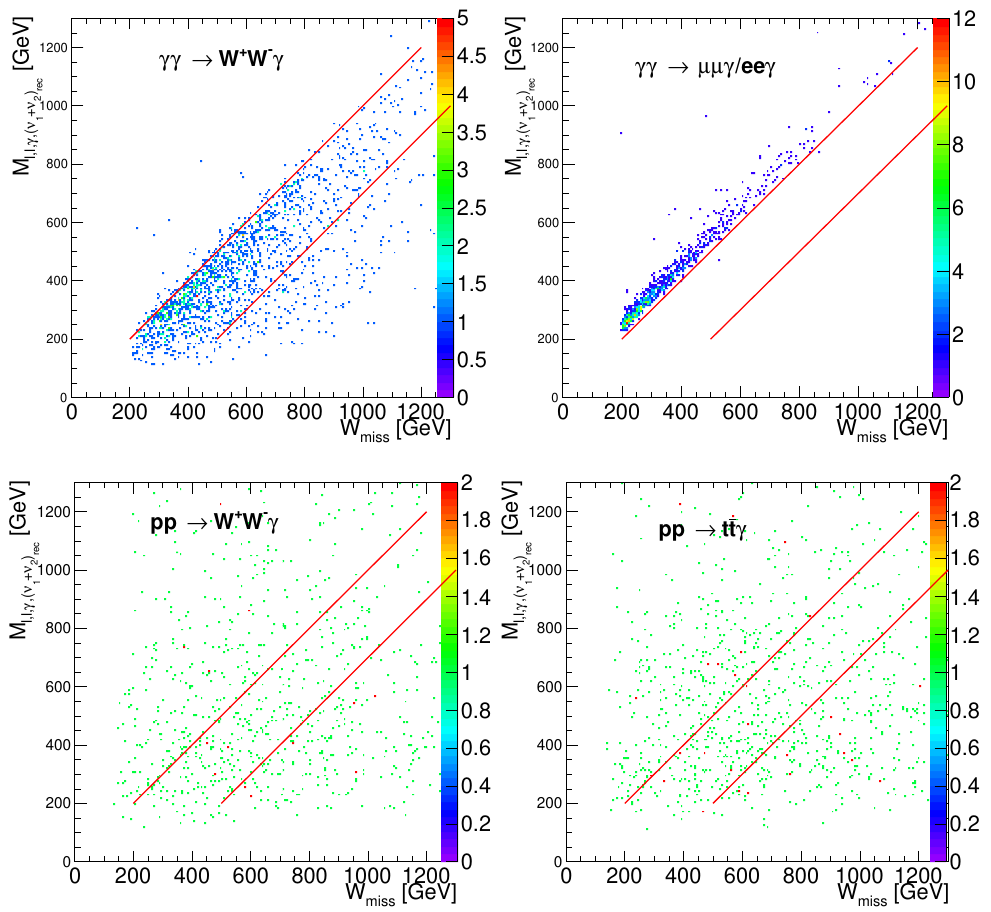
Figure 7 . Two-dimensional distributions of reconstructed invariant mass of central system versus protons missing mass. The constructed invariant mass is obtained by summation of four-momentum for two leptons, photon, and four-momentum sum of two neutrinos. The left-top and right-top plots show these two-dimensional distributions for (cid:13)(cid:13) ! W + W (cid:0) (cid:13) and (cid:13)(cid:13) ! l + l (cid:0) (cid:13) processes, respectively. The left-bottom and right-bottom plots belong to the inclusive W + W (cid:0) (cid:13) and t (cid:22) t(cid:13) processes superimposed by pile-up protons. The events surrounded between two red lines will be kept by the Type III